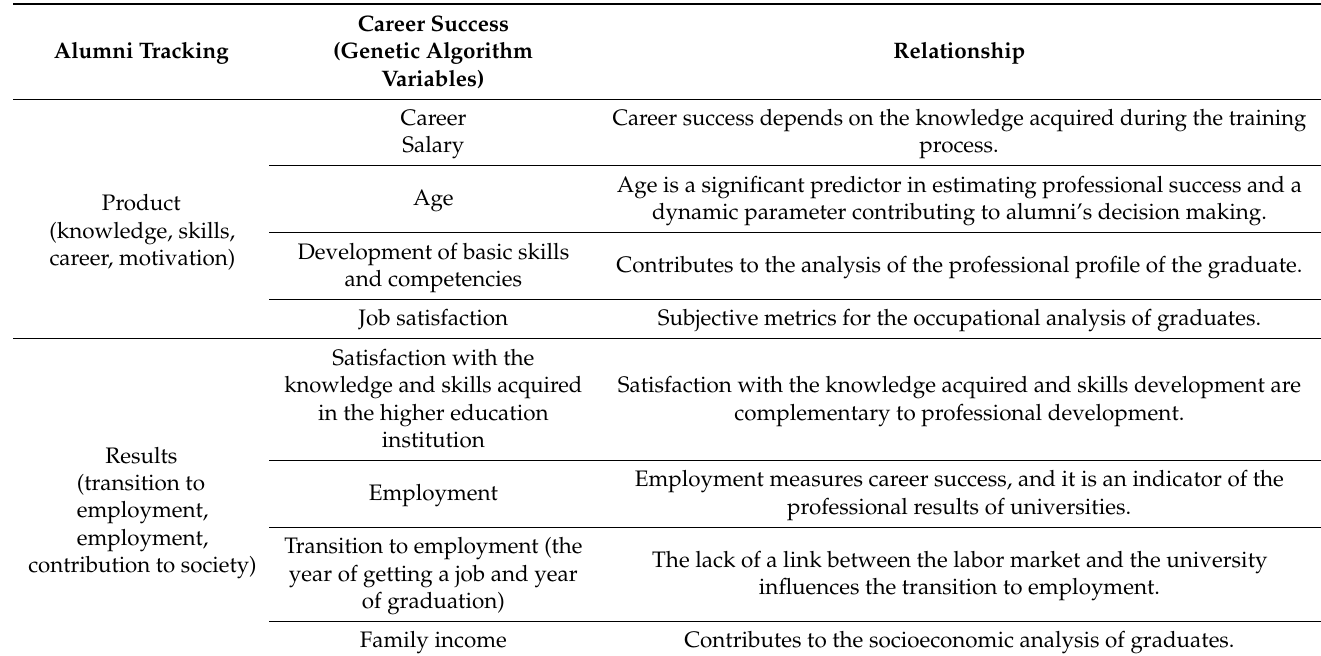
Table 9. Relationship of career success with the alumni